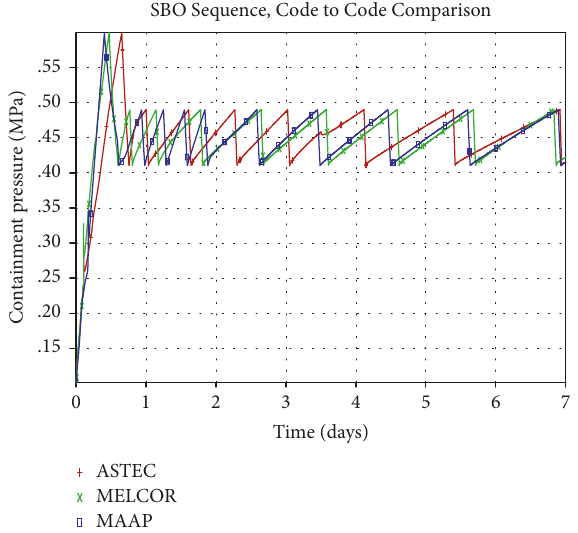
Figure 6: Pressure in the containment upper